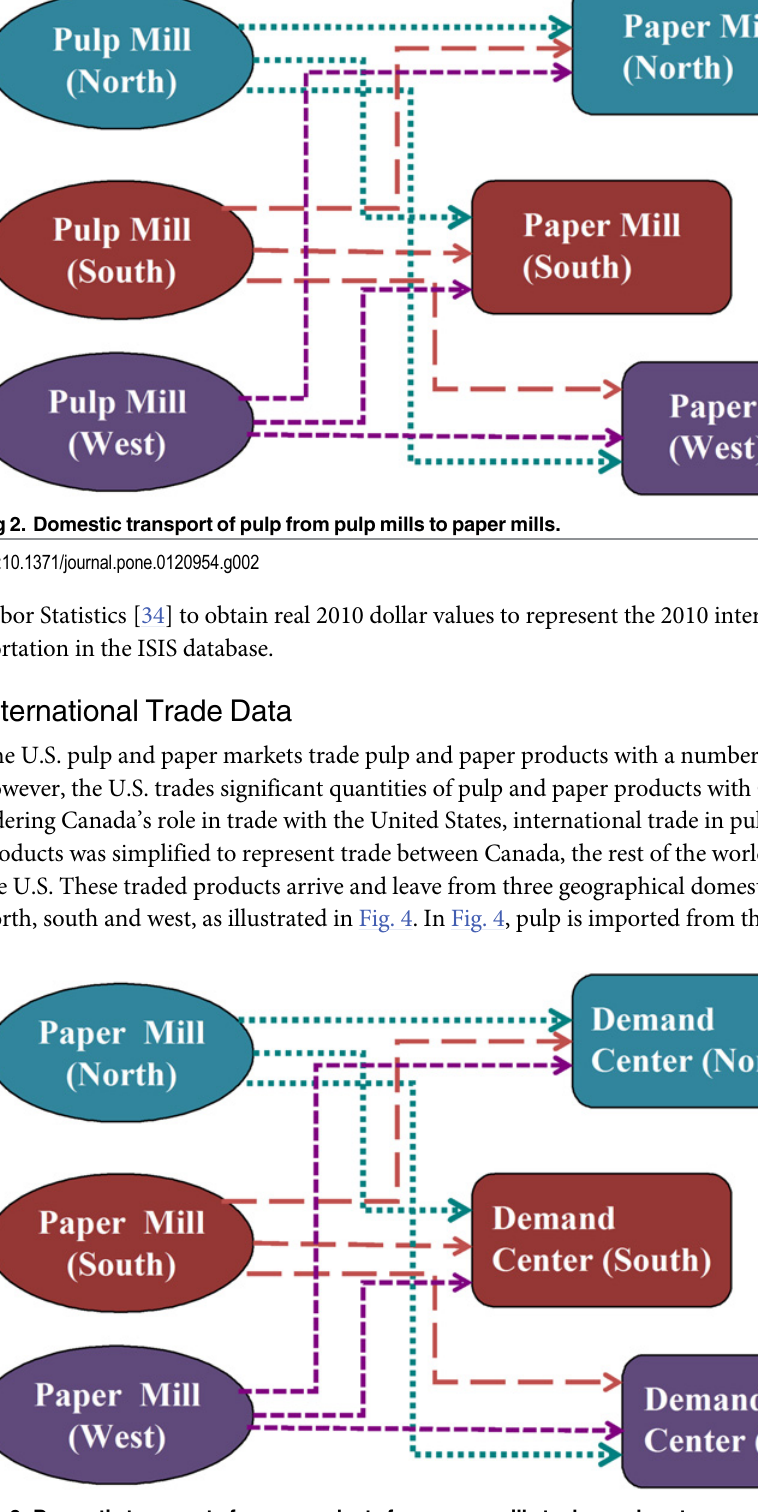
Fig 3. Domestic transport of paper products from paper mills to demand